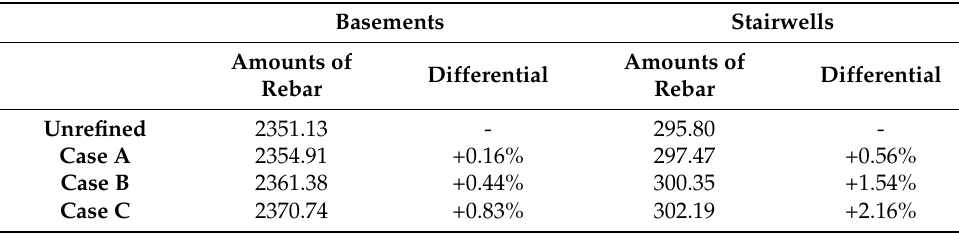
Table 9. Total amounts of rebar materials calculated and differentials from unrefined